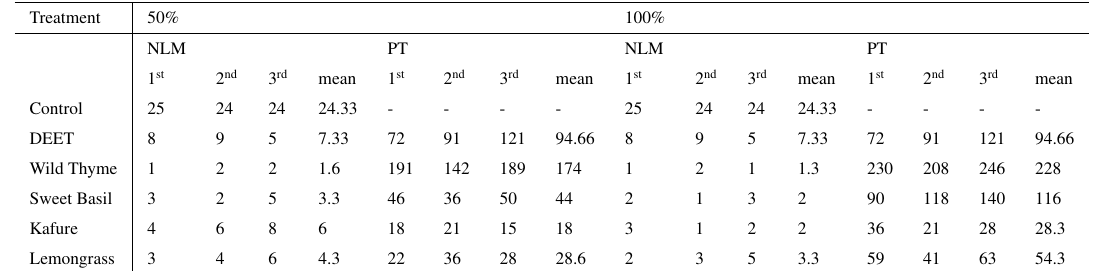
Table 4. Spatial repellent activity of 50% and 100% evaluated plants leaves hexane extract against Anopheles mosquito based on the number of landed mosquitoes (NLM) and protection time per minute (PT). Treatment